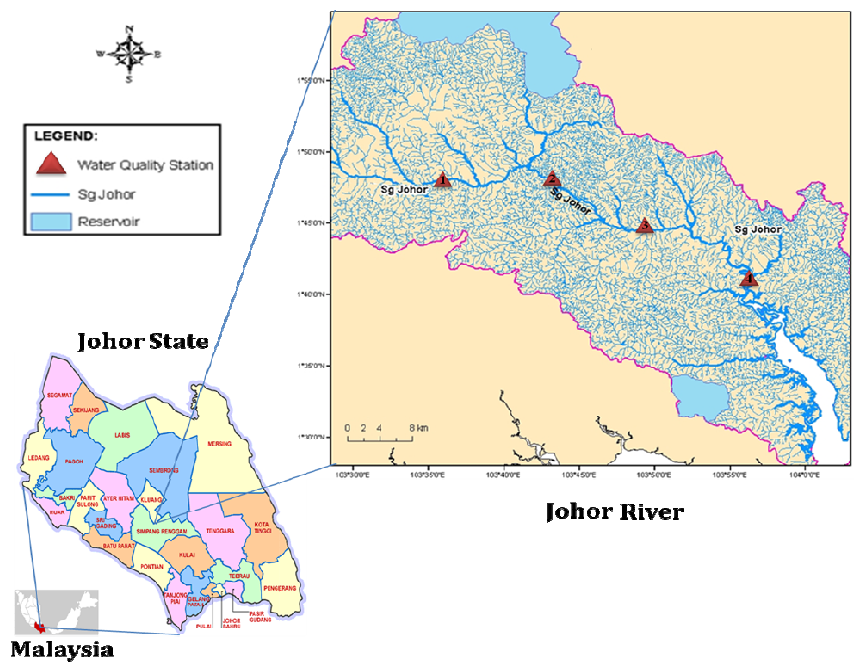
Fig. 1a: Map showing the geographical setting of the survey area with monitoring stations on the main stream